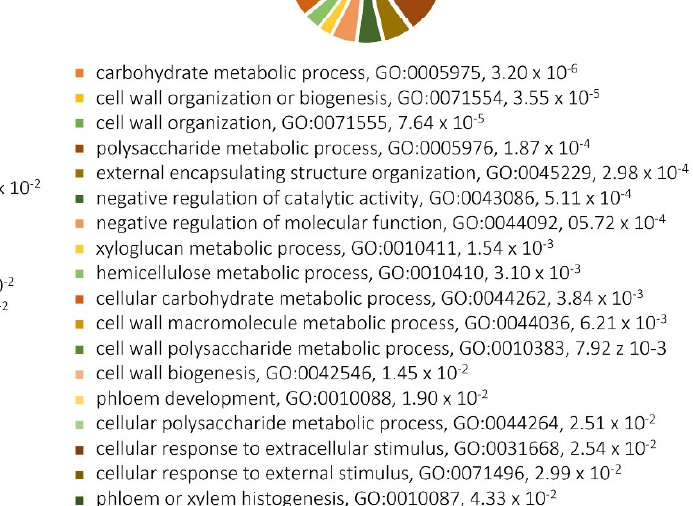
Figure 1. ( a ): Number of genes significantly more than 2-fold differentially expressed in symptomatic vs. non-symptomatic (BS/H) rachis tissues in the T1 and the T2 developmental stages; ( b ): Biological Process functional enriched categories in T1 and in T2; the name of the category with its GO ID number are reported next to the q -values giving the false discovery rates after Benjamini–Hochberg correction. Table 1. List of selected genes differentially expressed related to the cell wall metabolism in the rachis of BS grape clusters at stage T1 (pre-symptomatic EL-34,35, 2011) and at stage T2 (sympto- matic EL-36,37, 2011). Results are shown as log 2 FC and significance is based on an adjusted q -value of 0.05; significant results in bold letters. Further information is given in Table S1.